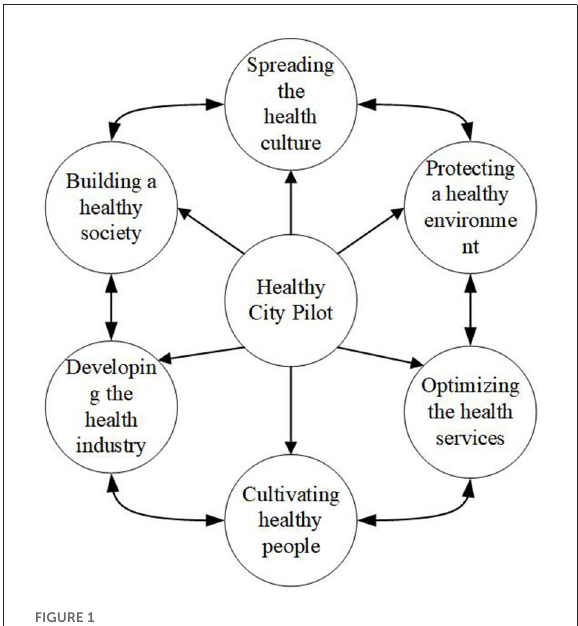
FIGURE1 Operation mechanism of a healthy